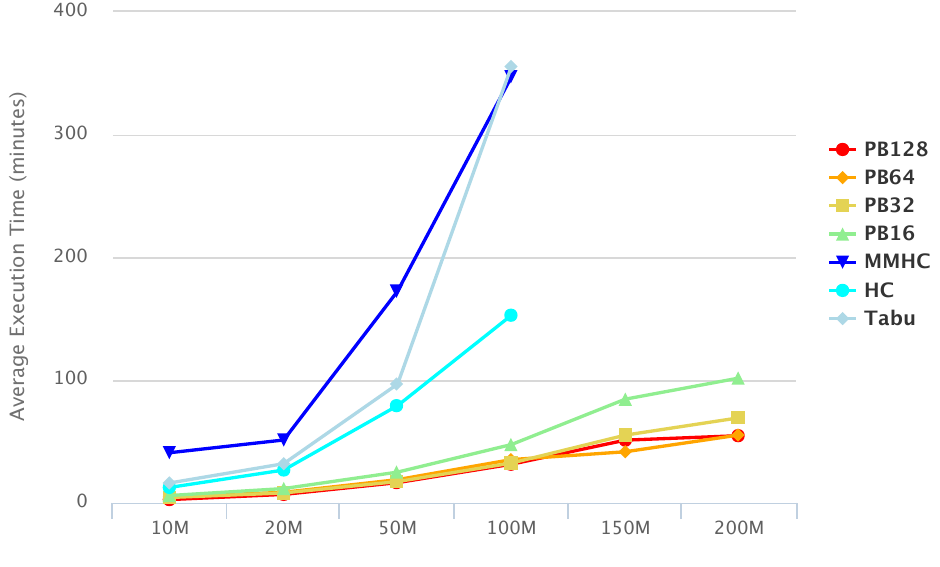
Figure 10. Alarm Set Execution